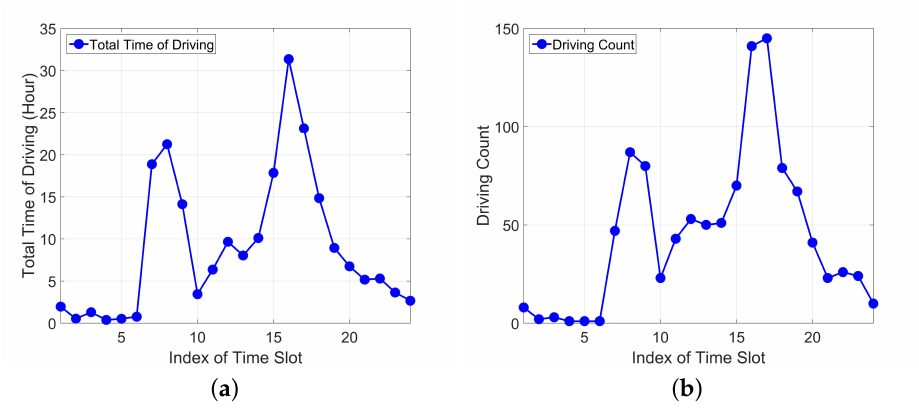
Figure 3. Statistical analysis on total time and total count for 1074 driving records. ( a ) Total time of driving at each time slot and ( b ) total count of driving at each time